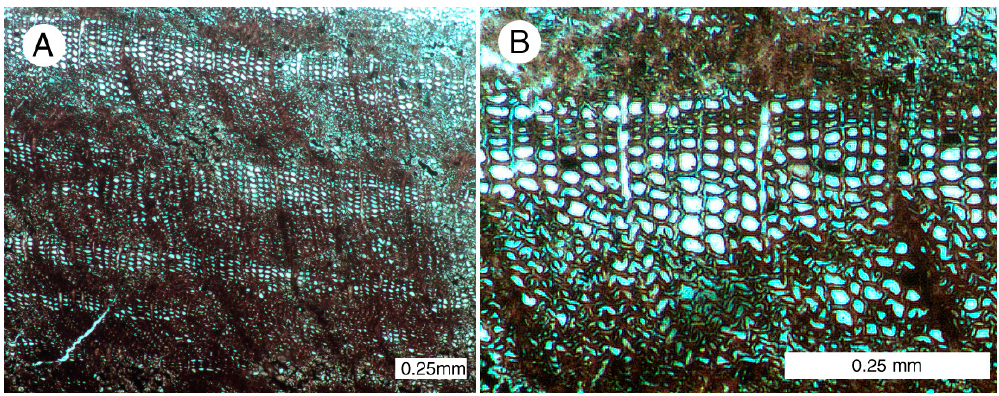
Figure 11. Permineralized Lower Eocene conifer wood, Red Hills Lignite Mine, Choctaw County, MS, USA. ( A , B ) Transverse orientation, showing organic mummified cell walls with lumina and intercellular space filled with silica.